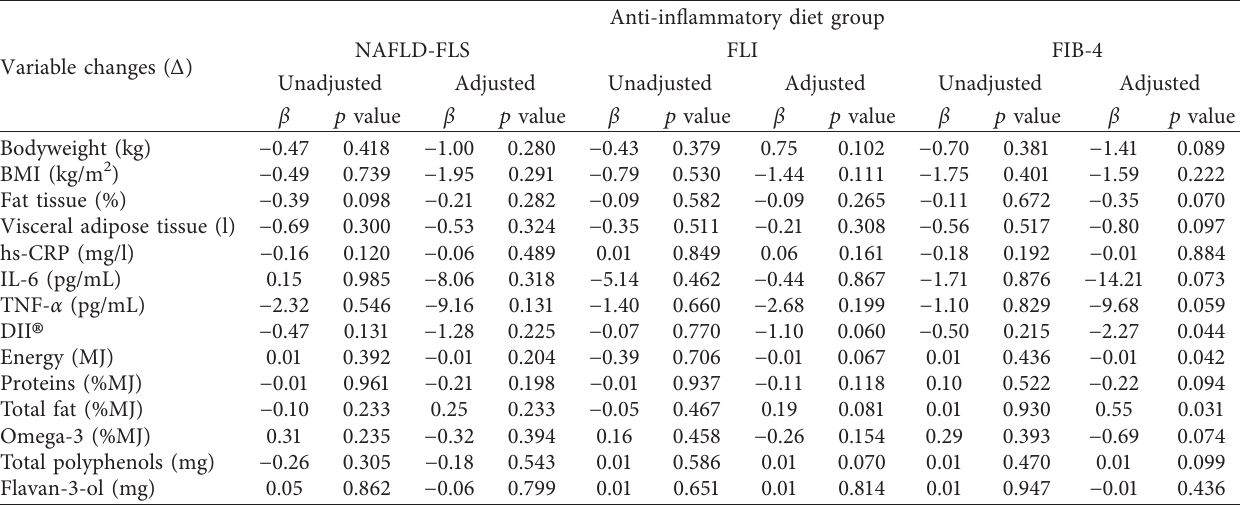
Table 4: Regression analyses of the liver parameters after 6 months of dietary intervention as dependent variables and changes in an- thropometric, biochemical, and dietary factors as independent variables in the AID group.